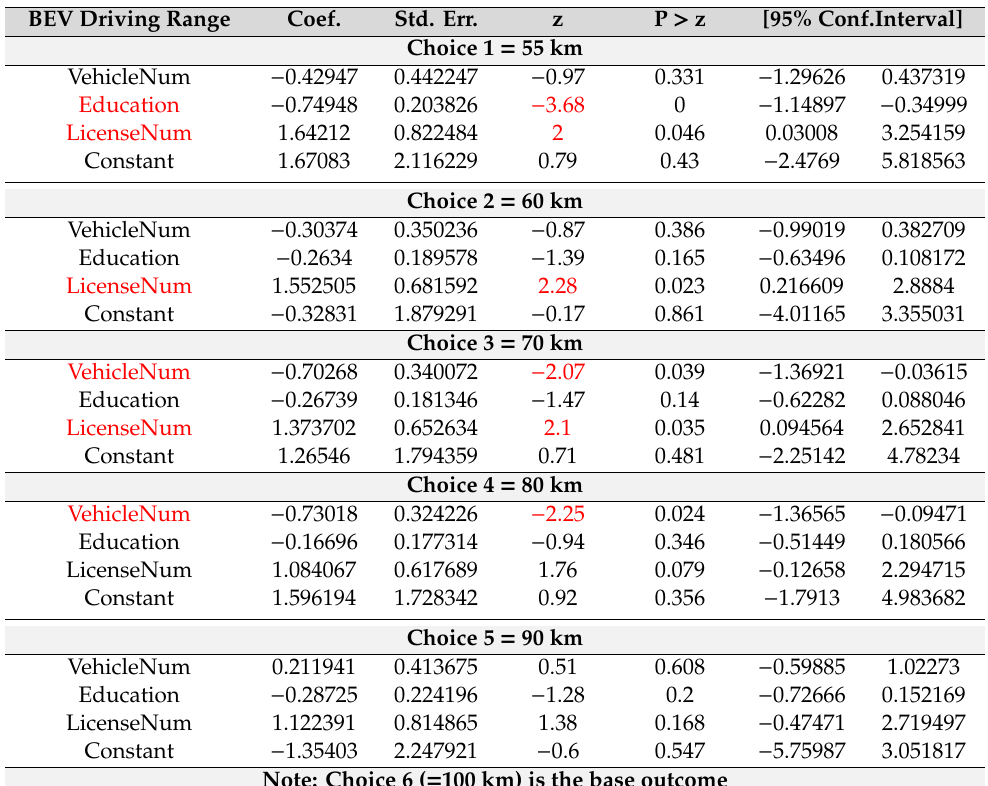
Table 4. MNL model for the minimum driving ranges of